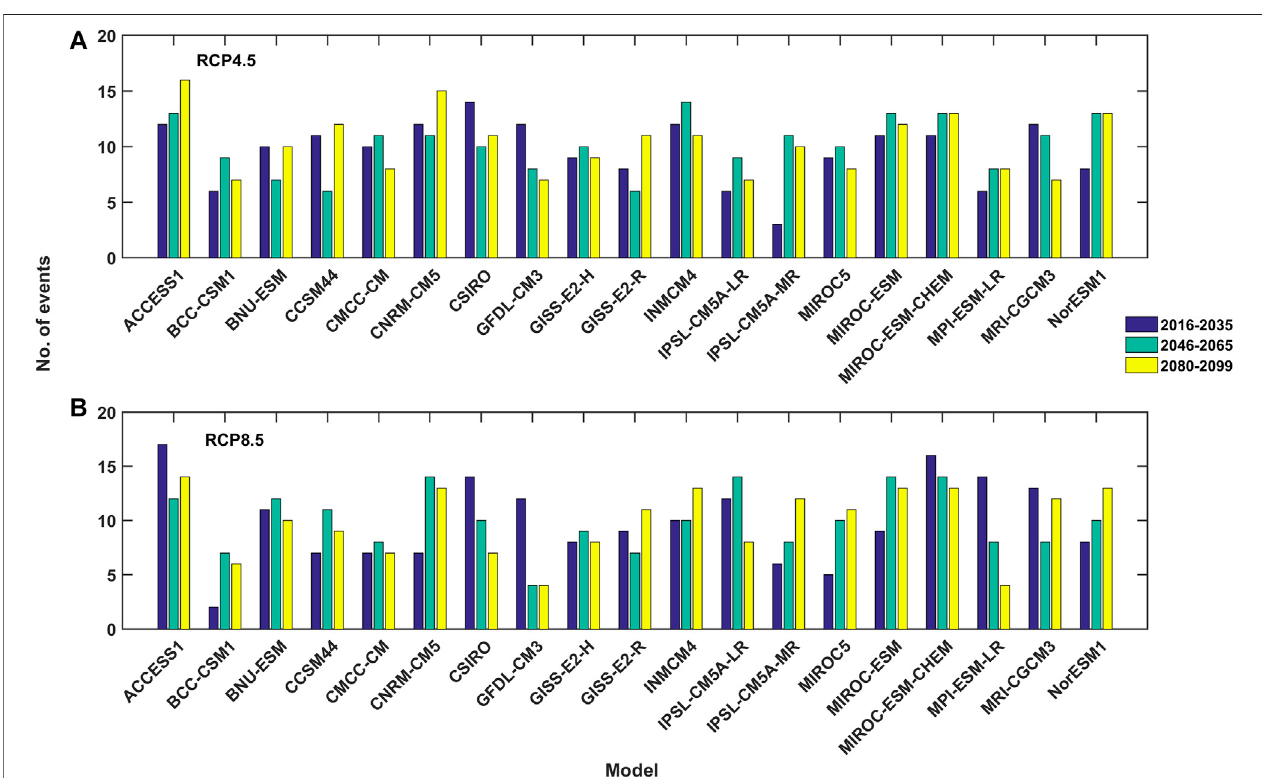
FIGURE7| NumberofQRAeventswith1.5ofstandarddeviationobtainedfromallmodelsduringJuneforthenear,midandfarfuturetermsunder (A) RCP4.5 (B) RCP8.5 emission scenarios.